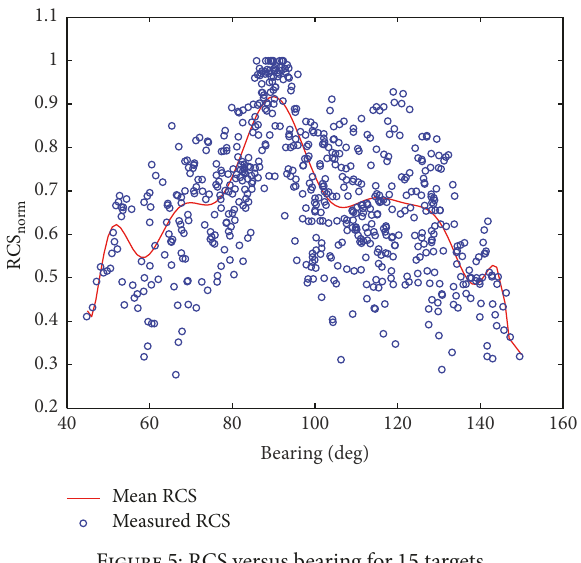
Figure 5: RCS versus bearing for 15 targets.